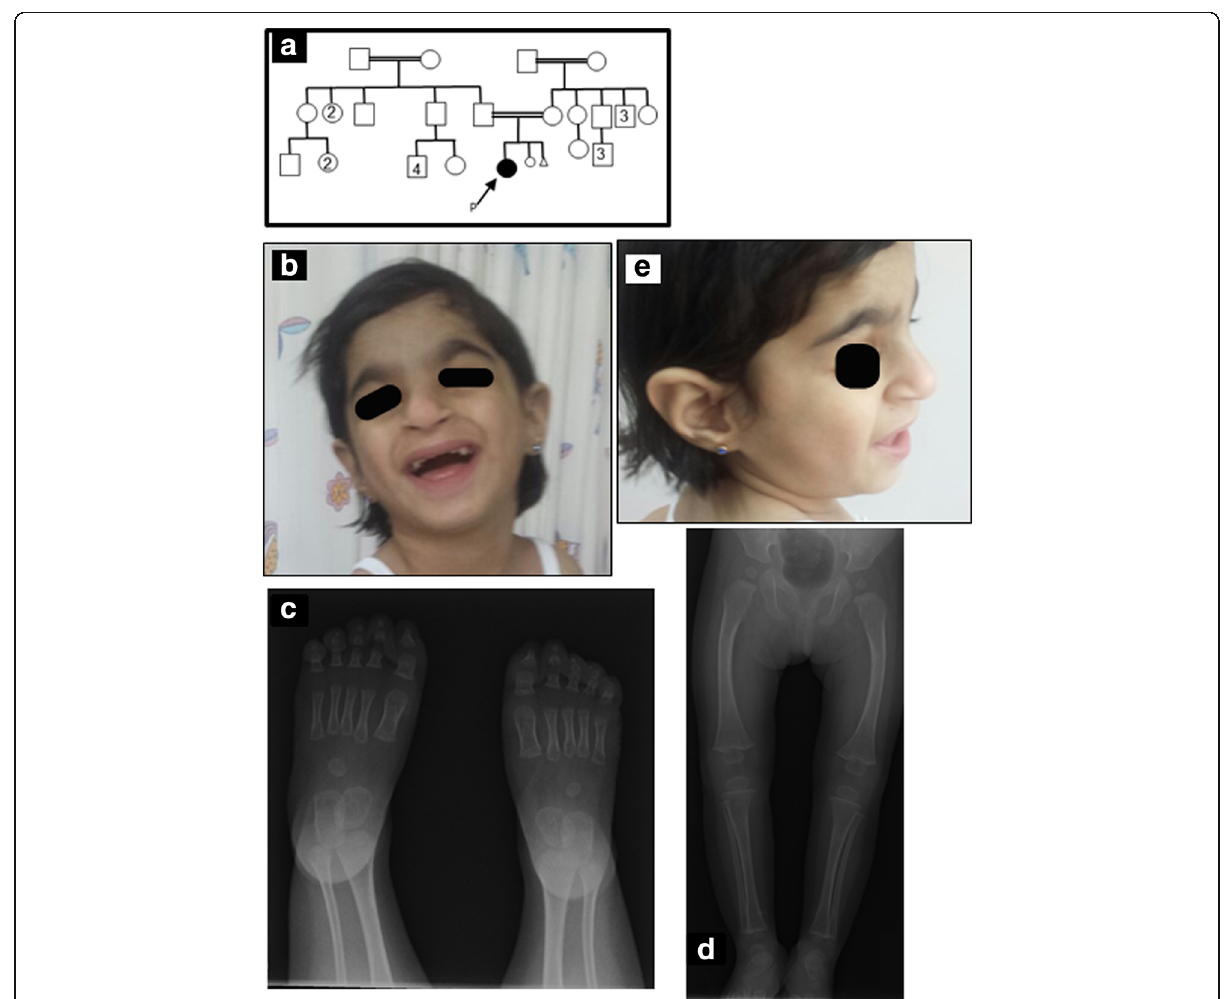
Fig. 1 Panel ( a ) shows the pedigree chart of the patient. Panels ( b ) and ( e ) show clinical features of the CTCF mutation in the patient, which